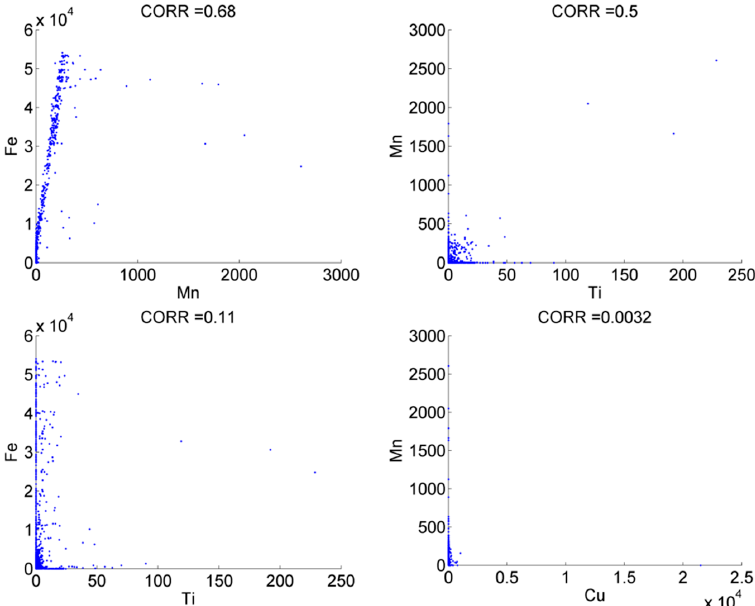
Figure 10. Correlations between characteristic X-ray intensities of Fe, Mn, Ti and Cu for polycentric agate.